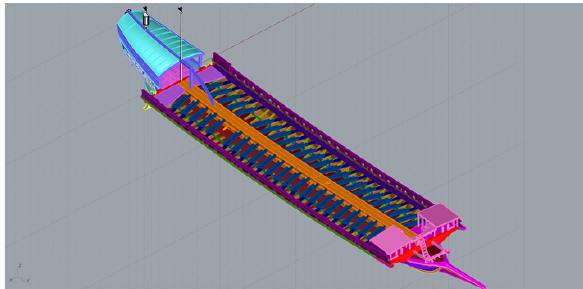
Figure 8. The digital model integrated by Chiggiato’s drawings